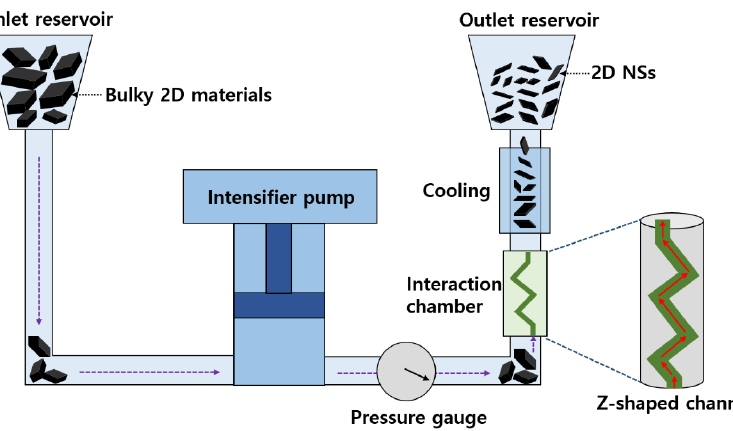
Figure 1. Schematic of a microfluidization process to produce few–layer 2D nanosheets (NSs) from bulk–like 2D